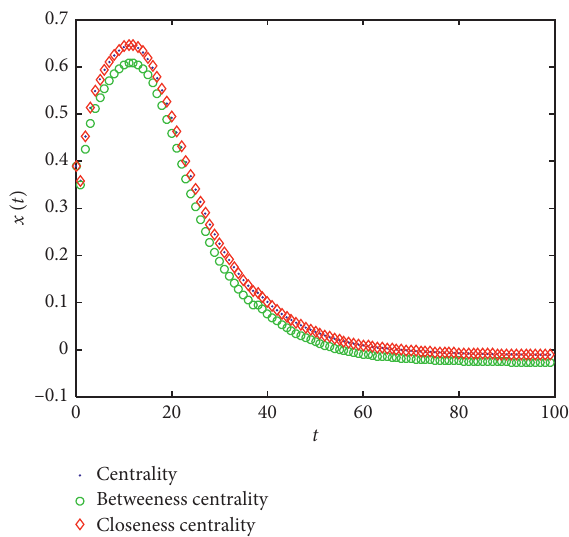
Figure 14: Evolution of average collective opinions based on three